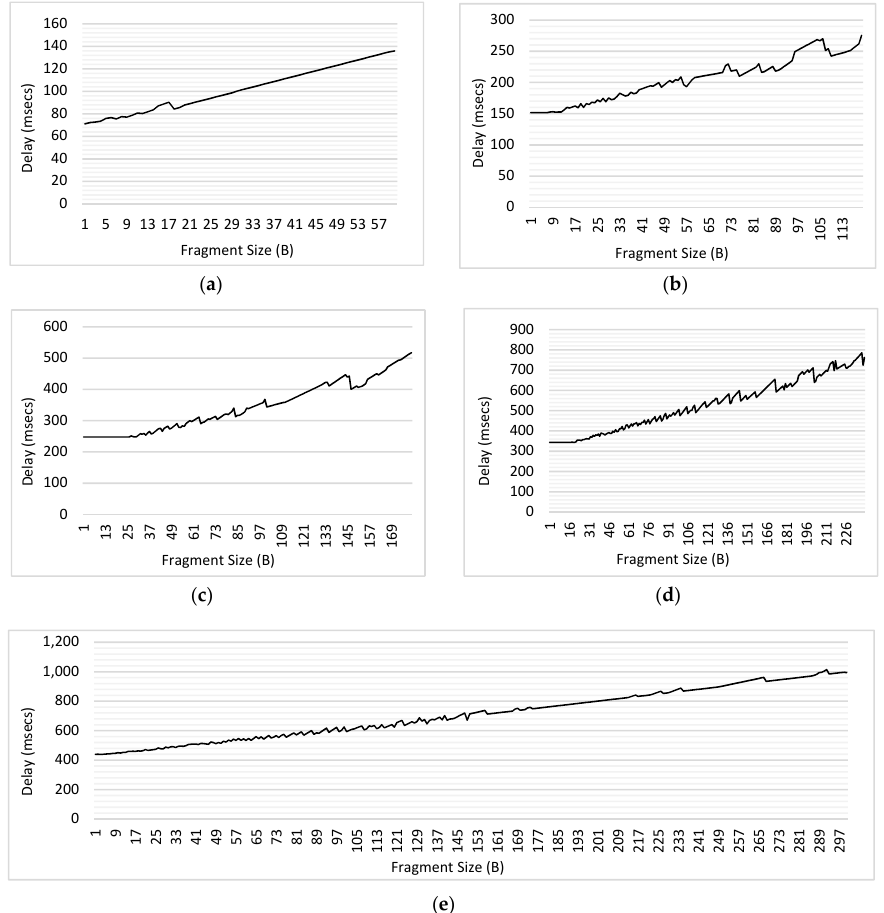
Figure 15. Influence of Varying Fragment Size for High Priority (Poisson) Traffic. ( a ) Packet Size = 60B; ( b ) Packet Size = 120B; ( c ) Packet Size = 180B; ( d ) Packet Size = 240B; ( e ) Packet Size = 300B.